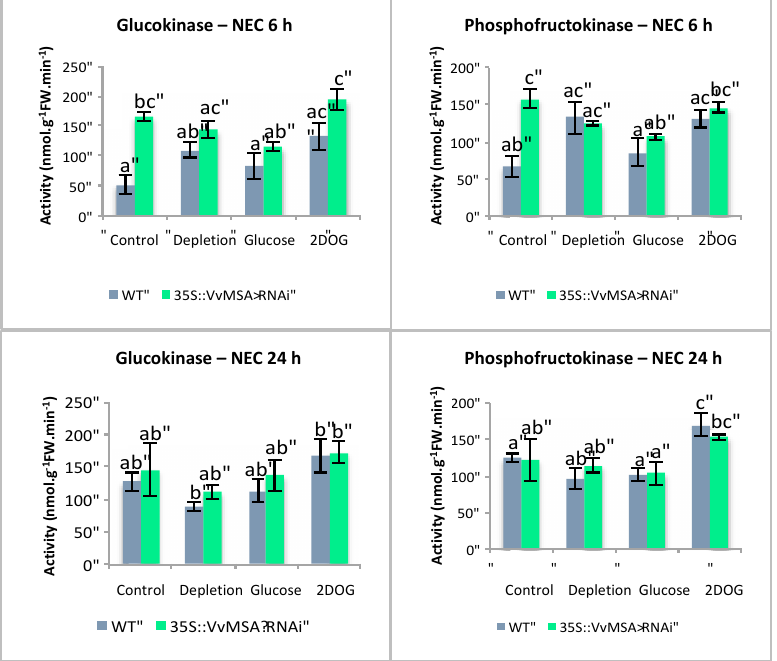
Figure 13. Activities of glycolysis-related enzymes in non-embryogenic (NEC) wild-type and 35S::VvMSA-RNAi cells. Studied conditions: Control—cells that were transfected in the complete GM + culture medium or the Gb medium for 30 h or 48 h; Depletion—cells that were transfected in the minimal GM° culture medium for 30 h or 48 h; Glucose and 2DOG—cells that were transfected in the minimal GM° culture medium for 24 h and treated with 10 mM glucose or 0.9 mM 2DOG for additional time periods of 6 or 24 h. Three independent biological repetitions were carried out for each of the studied conditions, with at least three technical replicates per biological repetition. The letters denote the groups that were found significantly different by ANOVA and Tukey’s HSD test ( p < 0.05) .